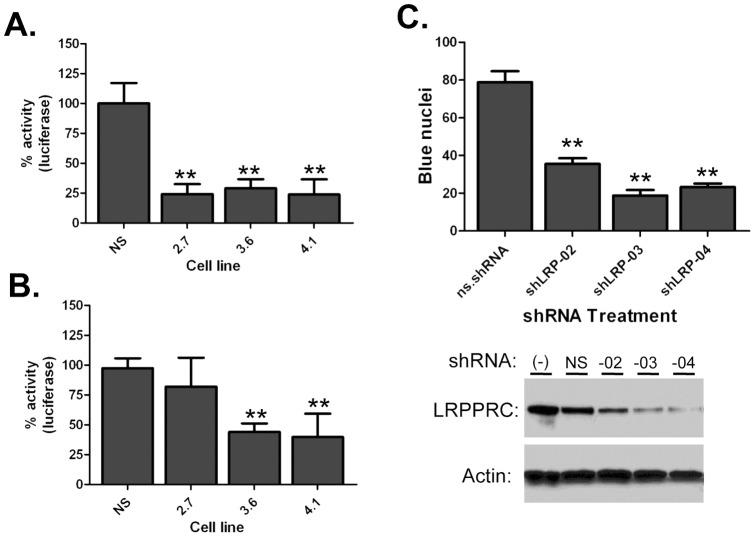
Knockdown of LRPPRC impairs HIV-1 infection.HIV-1 (A) and MLV (B) infection of cells stably depleted of LRPPRC. The indicated shLRPPRC cell lines were transduced with normalized levels of VSVg-pseudotyped HIV-1 and MLV luciferase viruses for 48 h. Data is normalized to the NS cells. ** Denotes p<0.001 as determined by two-tailed t-test, the error bars denote standard deviation, and the data is representative of at least three independent experiments. (C) Single cycle infectivity assays with LRPPRC-depleted cells. LRPPRC was transiently depleted in Hela-CD4-LTR-β-gal indicator cells with three LRPPRC-specific shRNAs (indicated on x-axis) 24 hrs prior to infection with HIV-1. Infectivity was measured by counting blue nuclei (indicated on y-axis). Example of transient knockdown of LRPPRC in Hela-CD4-LTR-β-gal cells is shown below the graph by anti-LRPPRC and anti-actin Western blots. Data is the average of 9 independent infections and ** denotes p<0.001 as determined by two-tailed t-test. Error bars denote SEM.